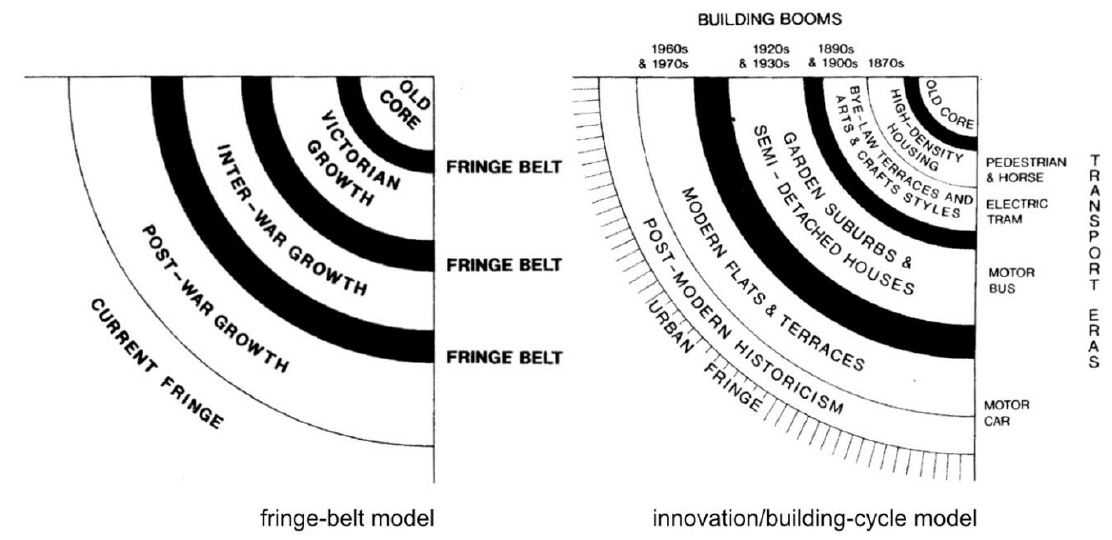
Figure 1 Conzen’s fringe - belt model and Whitehand’s innovation/building cycle